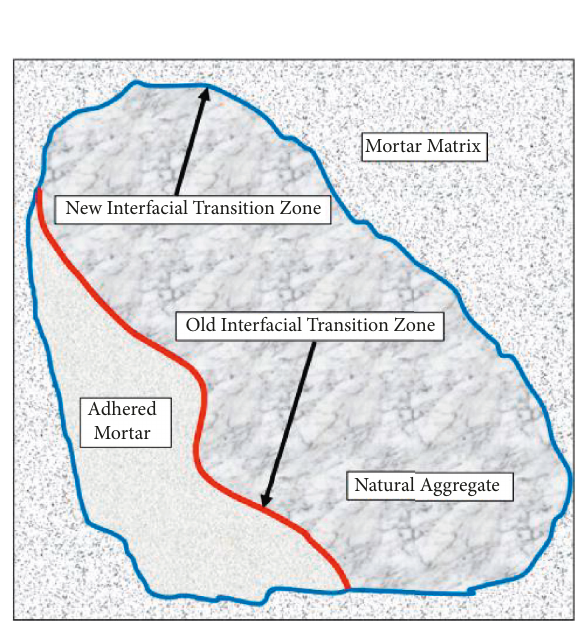
Figure 2: Schematic diagram of recycled coarse